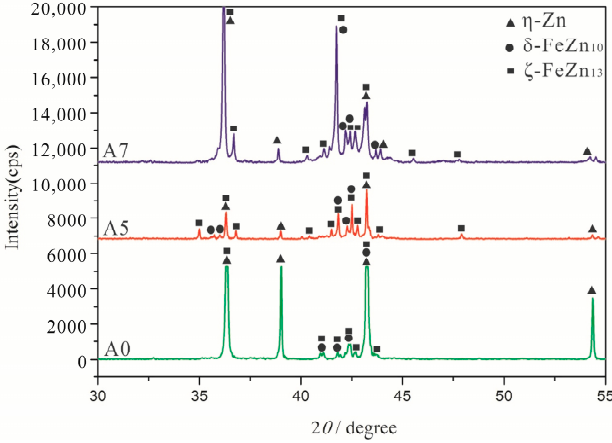
Figure 6. X-ray diffraction patterns of corrosion products of the A0, A5 and A7 alloys at 520 °C.